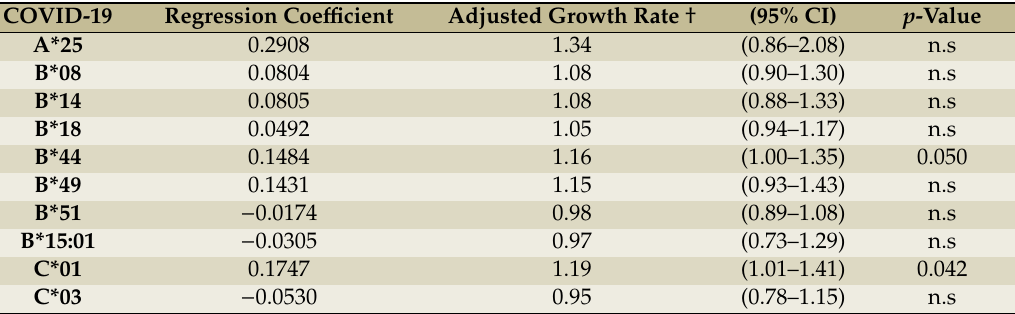
Table 2. – Multiple regression model: COVID-19 incidence rate and HLA.